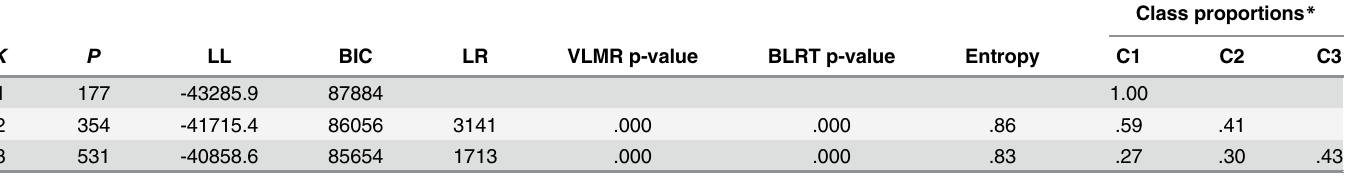
Table 2. IRT Mixture Analyses of the Pain Item